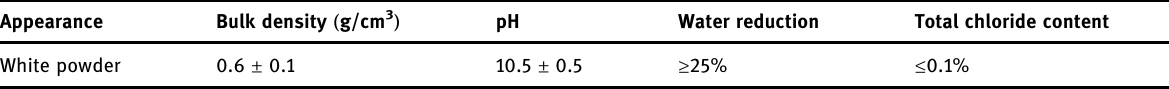
Table 7: Performance parameters of polycarboxylate superplasticizer